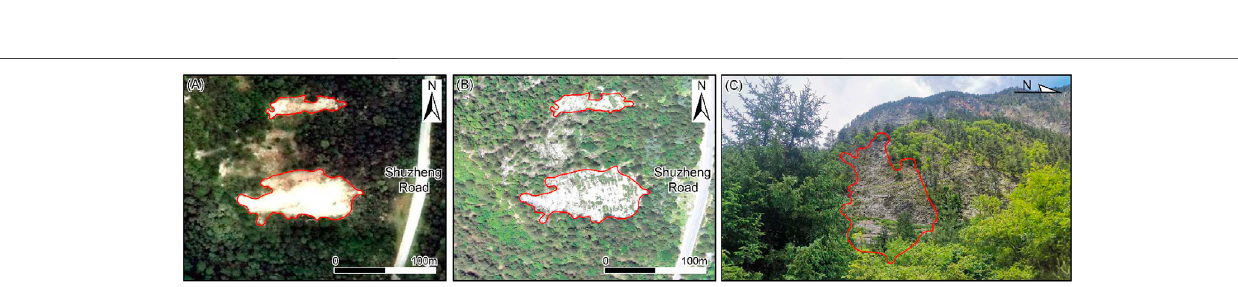
Frontiers in Earth Science |